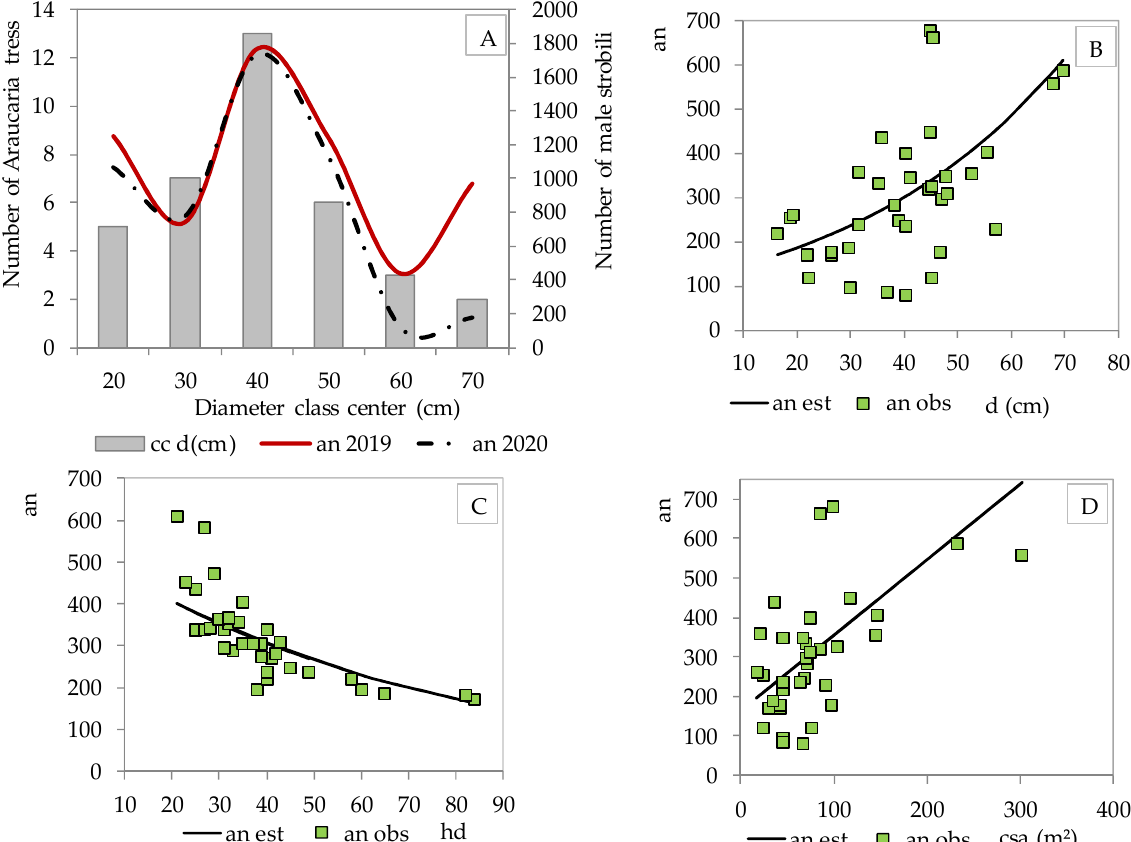
Figure 3. ( A ) Number of male strobili (an) counted per diameter class and total for the two sampling periods (2019 and 2020, respectively); ( B – D ) accuracy of the adjusted models for Araucaria angustifolia trees for the relationship between male stobili production and dendrometric and morphometric variables. Table 2. The equation for the number of male strobili in A. angustifolia trees as a function of dendro- metric and morphometric variables and their statistical fitted. Equation b 0 SE